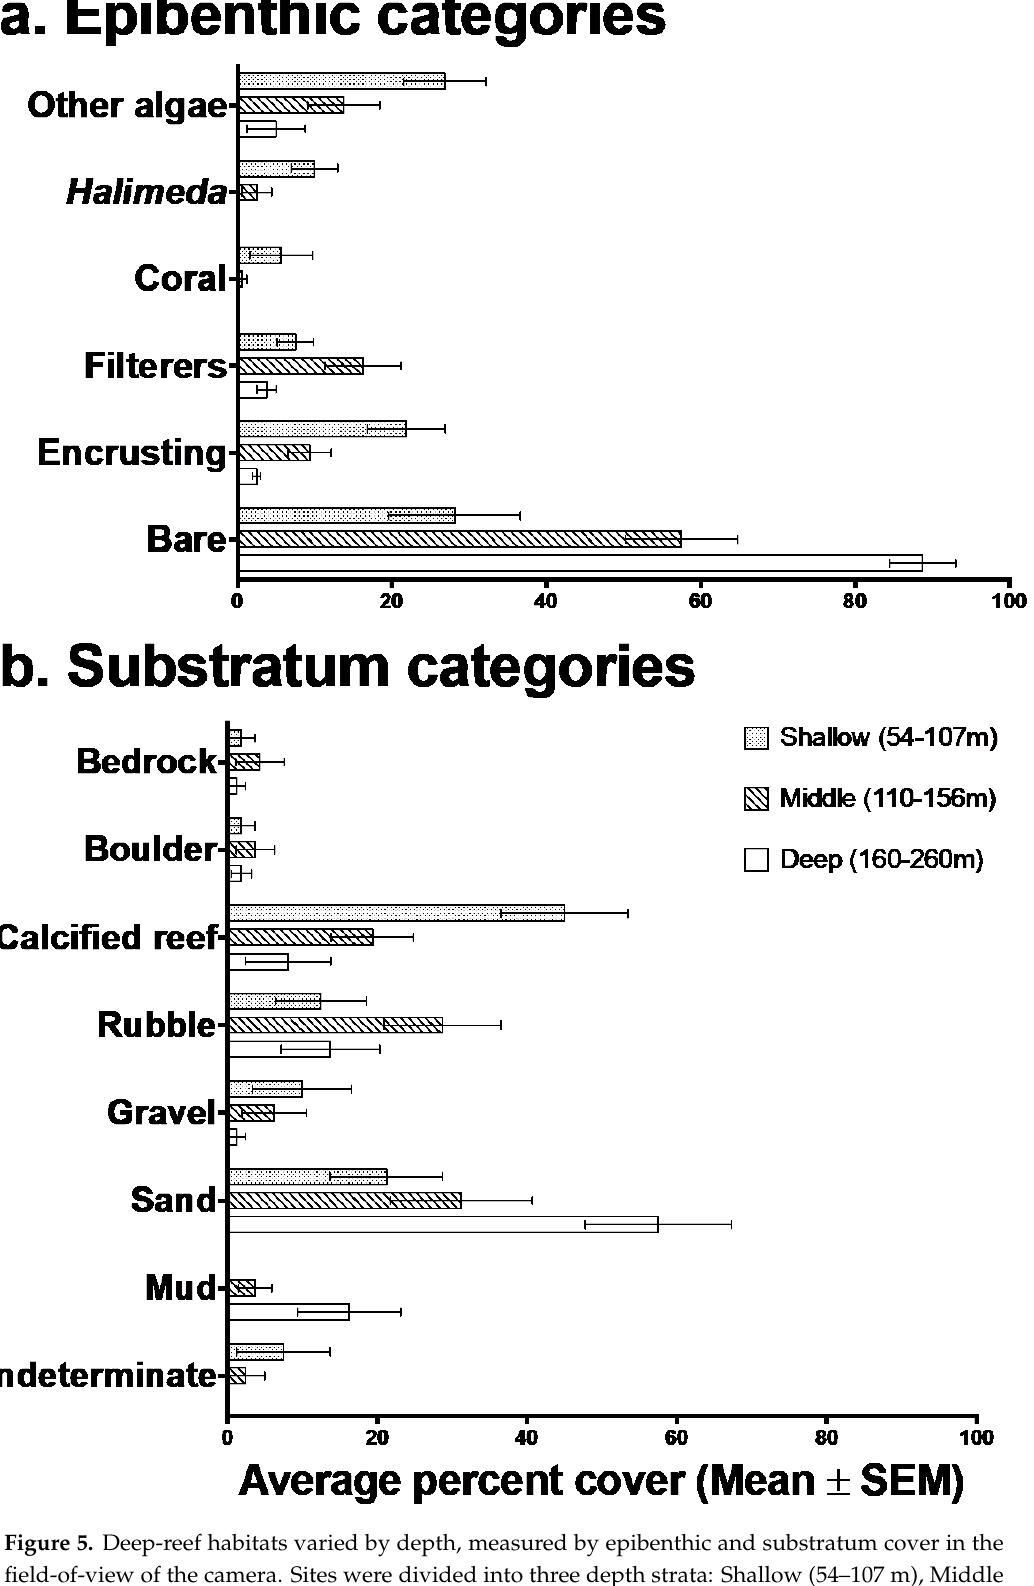
Figure 5. Deep-reef habitats varied by depth, measured by epibenthic and substratum cover in the field-of-view of the camera. Sites were divided into three depth strata: Shallow (54–107 m), Middle (110–156 m), and Deep (160–260 m) represented by three sequentially stacked bars (each n = 16 sites) with error bars for the standard error of the mean percent cover.